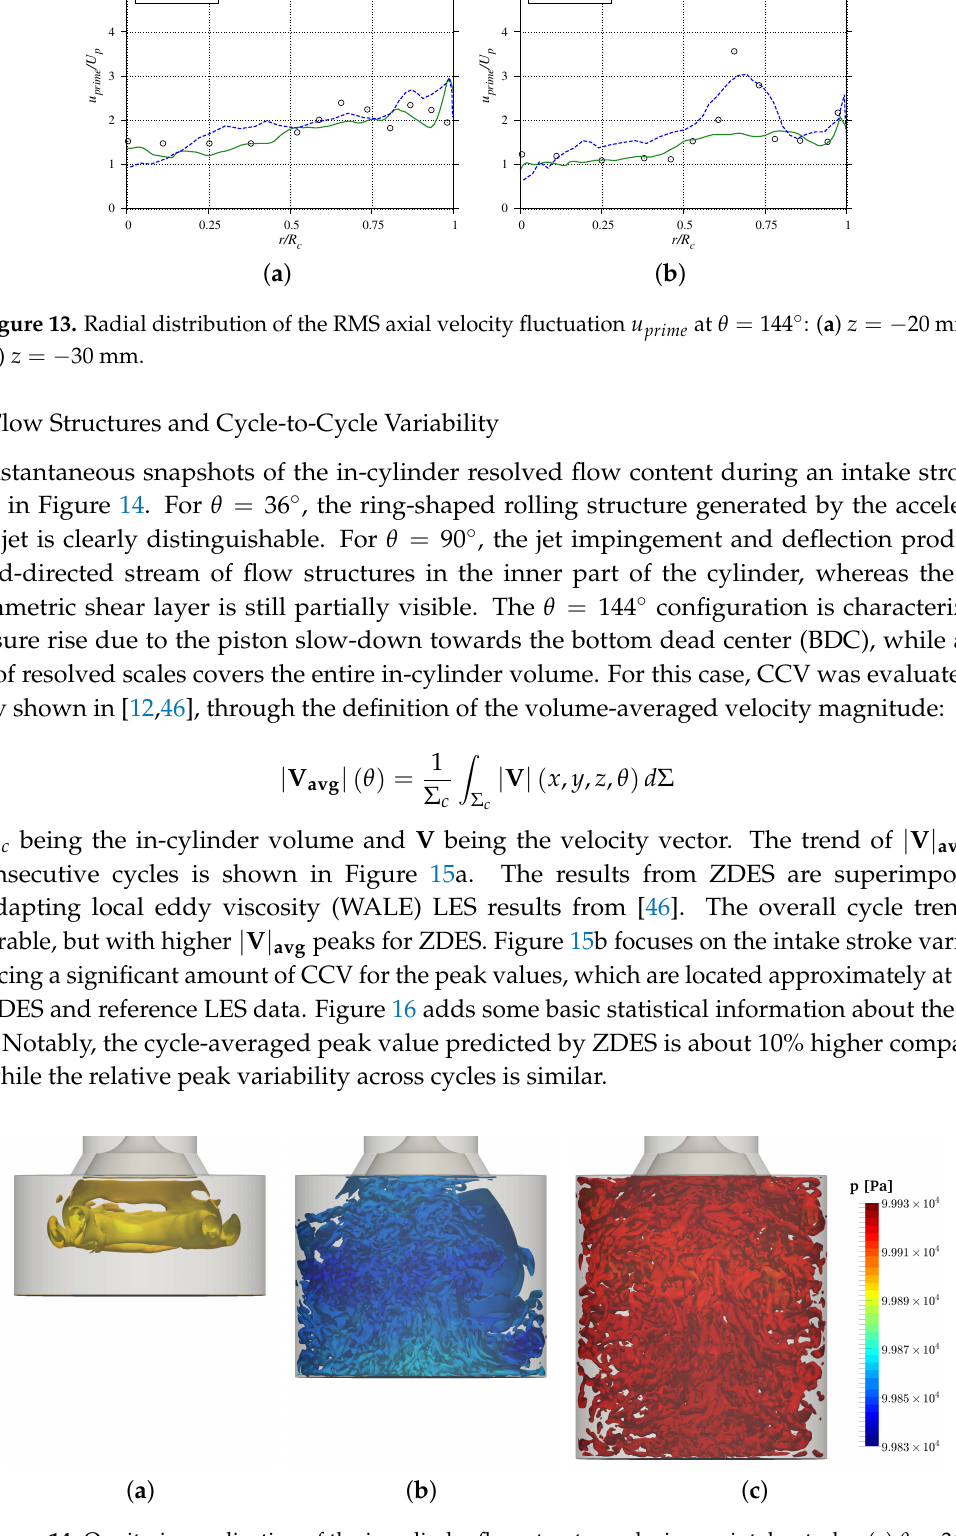
Figure 14. Q-criterion realization of the in-cylinder flow structures during an intake stroke: ( a ) θ = 36 ◦ ; ( b ) θ = 90 ◦ ; ( c ) θ = 144 ◦